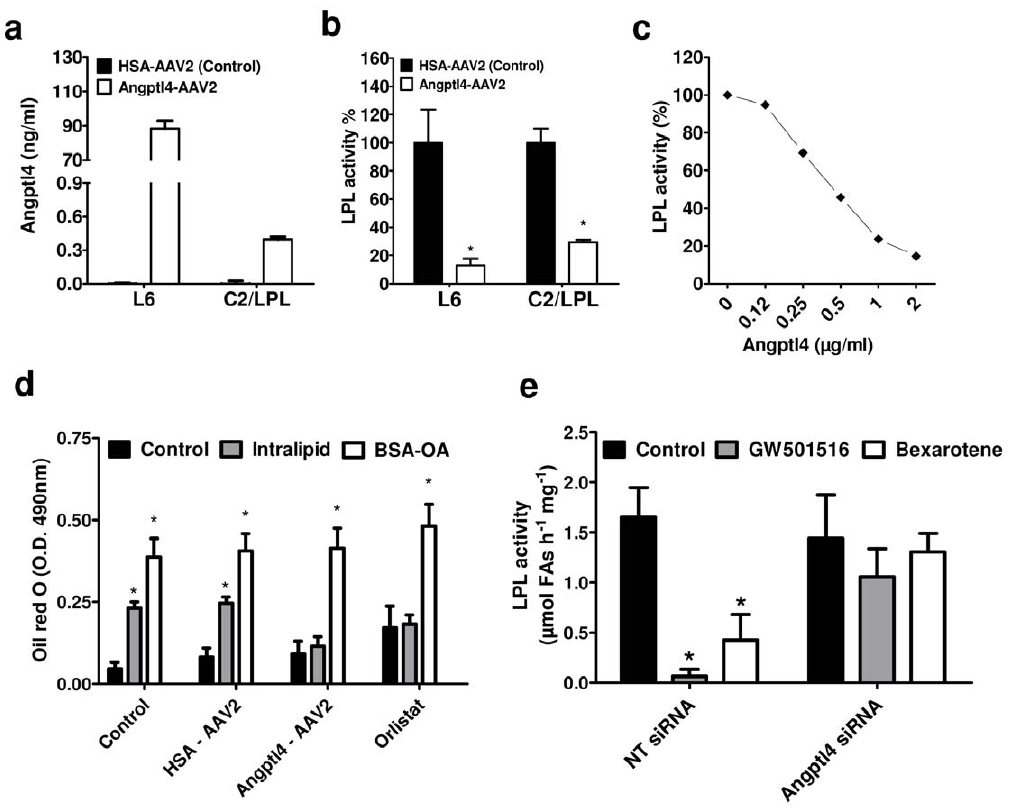
Figure 6. Angptl4 inhibits LPL activity and LPL-dependent fatty acid uptake and mediates PPAR d effect on LPL activity. ( a ) Human Angptl4 concentration was evaluated by ELISA in medium from myotubes infected with HSA (human serum albumin)-AAV2 (Control) or hAngptl4- AAV2. ( b ) Heparin releasable LPL activity was measured in myotubes infected with HSA-AAV2 (Control) or hAngptl4-AAV2, n=4 for L6 and n=3 for C2/LPL. LPL activity expressed as 100% represent 0.037 (L6) or 3.38 (C2/LPL) m mol FAs h 2 1 mg 2 1 . ( c ) Heparin releasable LPL activity was measured in C2/LPL myotubes exposed to increasing concentration of recombinant hAngptl4. LPL activity expressed as 100% represent 2.58 m mol FAs h 2 1 mg 2 1 . ( d ) Myotubes infected with HSA-AAV2 or Angptl4-AAV2 or treated with Orlistat (50 m M) were incubated 16 h with Intralipid or OA-BSA. Oil Red